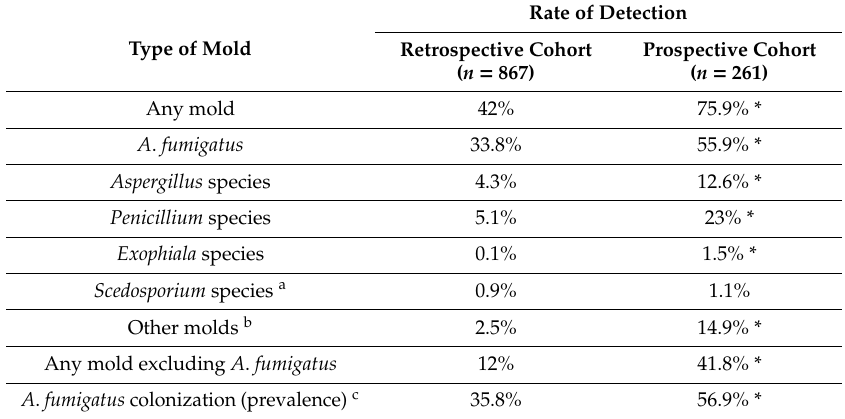
Table 1. Detection rate of molds in the sputum samples of cystic fibrosis (CF)